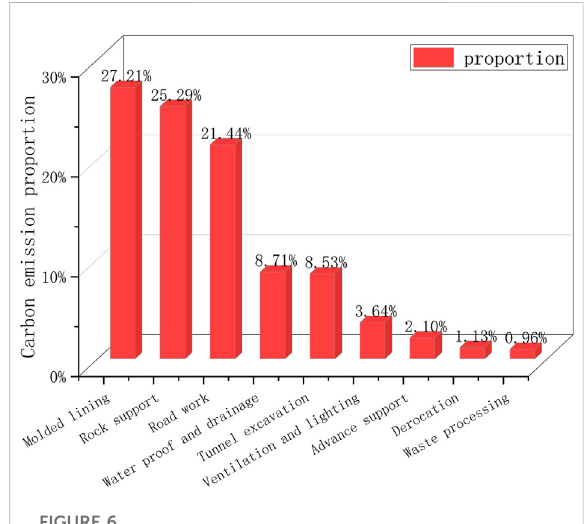
FIGURE 6 Carbon emission proportion in different procedure in tunnel